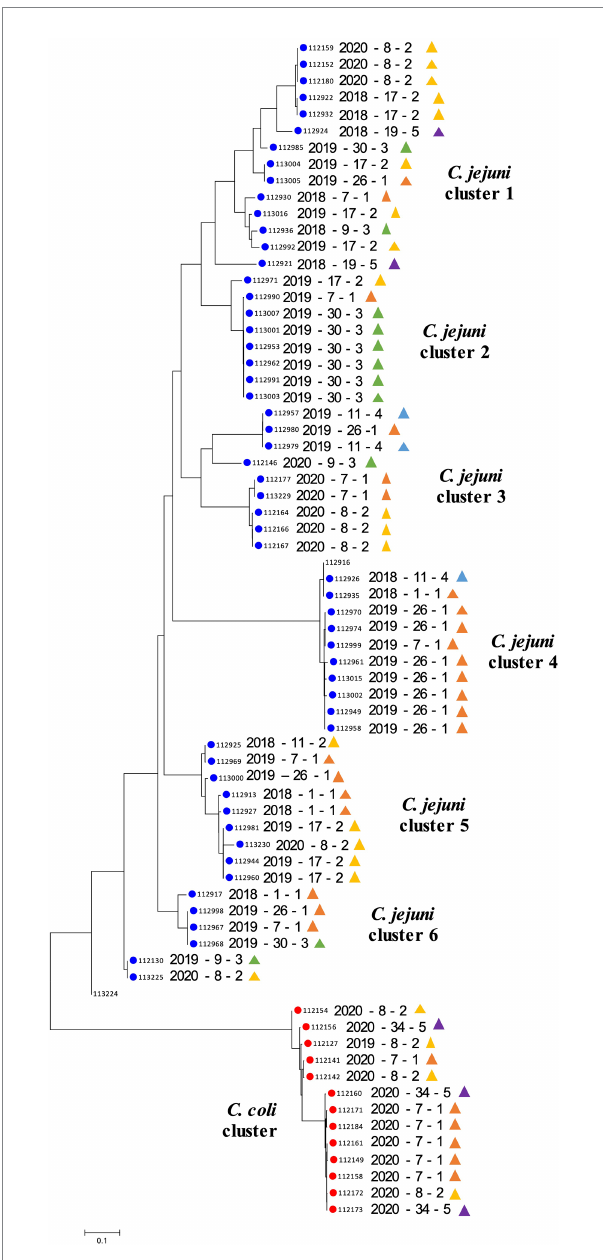
FIGURE 2 Phylogenetic diversity based on single nucleotide polymorphisms (SNPs) analysis. The phylogenetic tree was constructed using the Neighbor-Joining method. The optimal tree with the sum of branch length = 2.14 is shown. The tree was generated to scale with branch lengths in the same units as those of the evolutionary distances used to infer the phylogenetic tree. The analysis involved 69 genomes. There was a total of 2,748 positions in the final dataset. The scale bar represents a 0.1 base substitution per site. Each row indicates a specific Campylobacter isolate (year of collection—farm ID—farm cluster). Blue and red circles indicate Campylobacter jejuni and Campylobacter coli, respectively. Colored triangles are associated with the farm cluster number; orange, yellow, green, blue and purple triangles indicate farm clusters 1 to 5, respectively (Figure